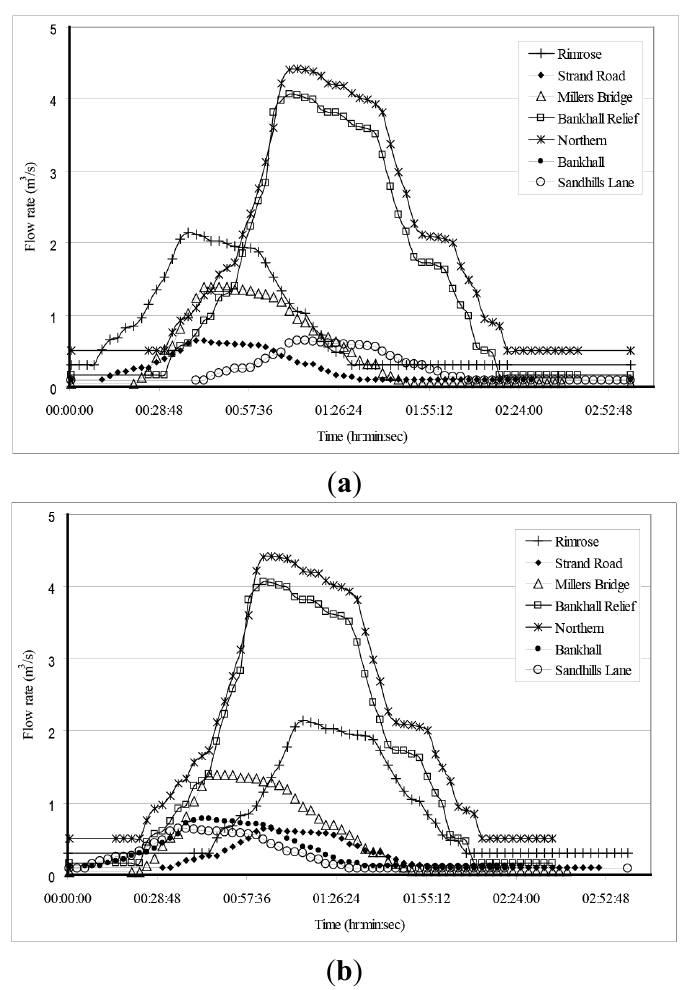
Figure 3. ( a ) Stormwater runoff hydrograph for migrating downstream storms; ( b ) Stormwater runoff hydrograph for migrating upstream